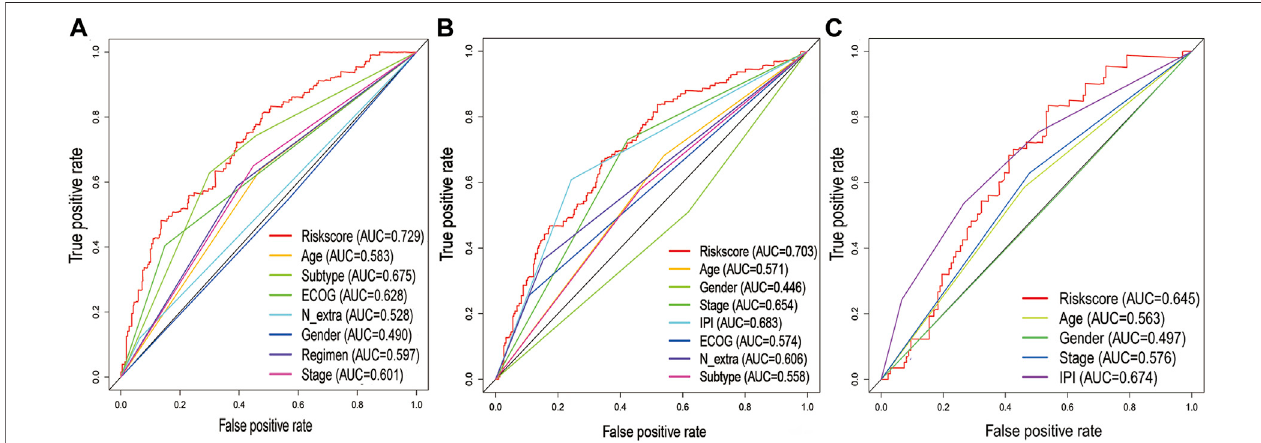
FIGURE5| Comparisonof3-yearROCcurveswithothercommonclinicalcharacteristicsshowedthesuperiorityofthegenesignature. (A) GSE10846dataset. (B) GSE31312 dataset. (C) NCICCR dataset.